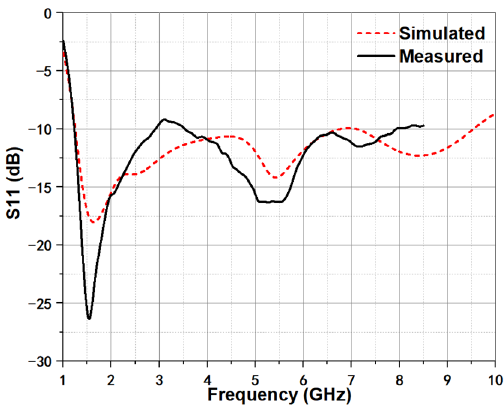
Figure 8. Simulated and measured return loss of compact UWB TSA.